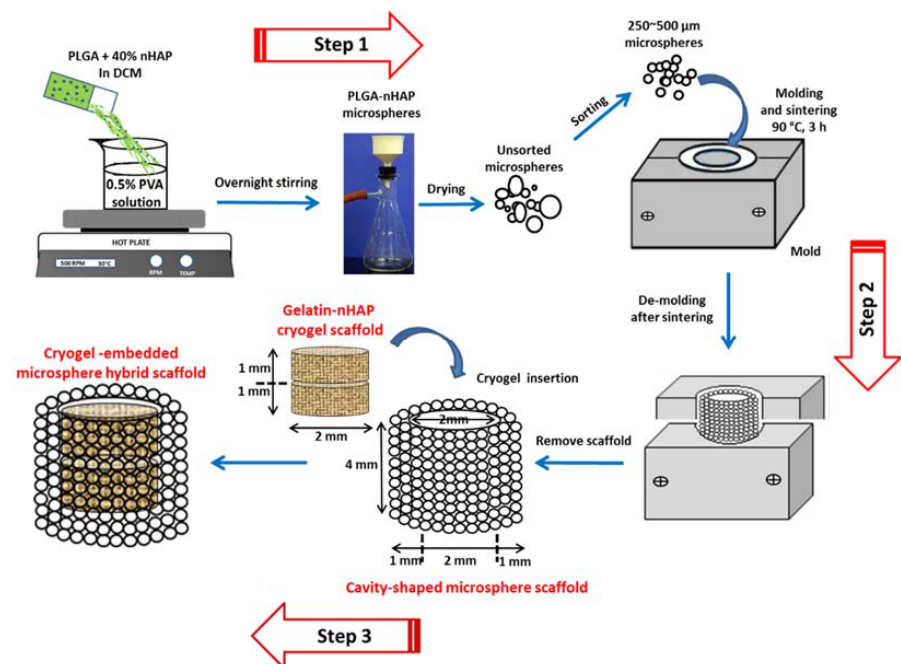
Figure 1. Preparation of PLGA ‐ nHAP microspheres through emulsification using 0.5% PVA solution ( Step 1 ) and further sorting and sintering of 250~500 μ m PLGA ‐ nHAP microspheres to obtain cavity ‐ shaped microsphere scaffold with 2 ‐ mm inner diameter, 2 ‐ mm bottom thickness and 1 ‐ mm